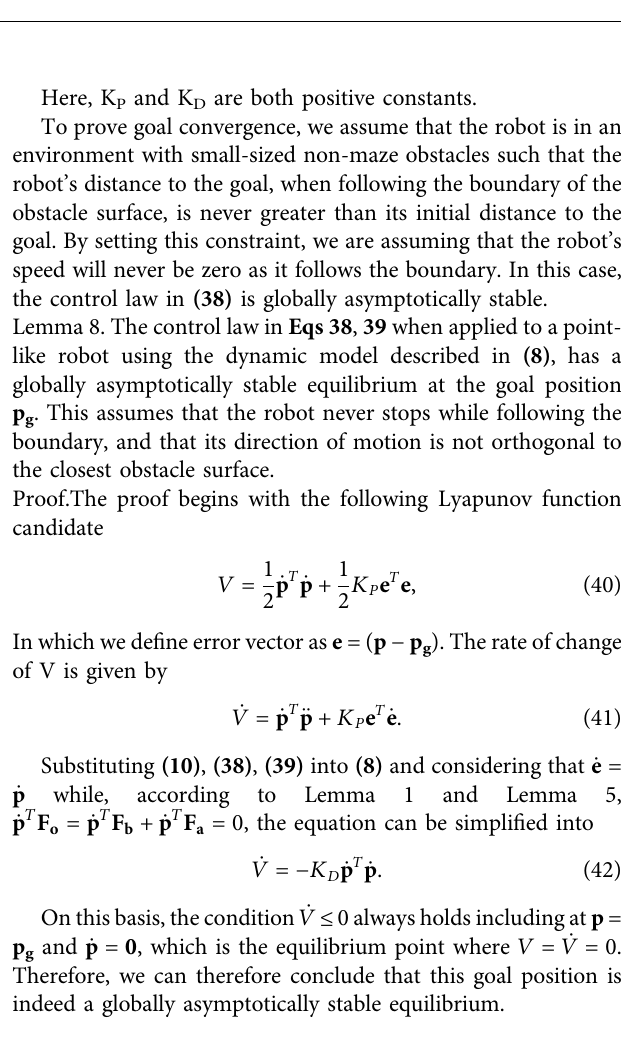
, (B) the case where κ (cid:1) 1 r